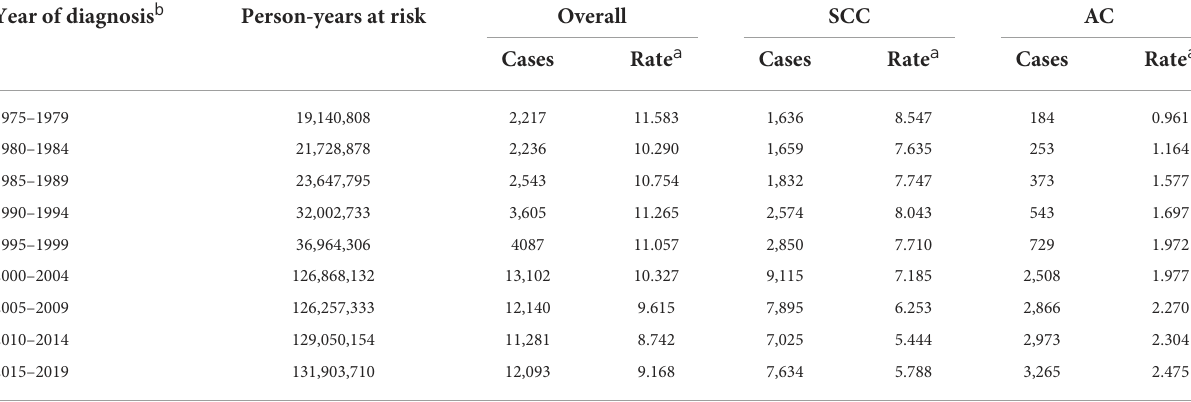
TABLE 1 Cases and rates on cervical cancer incidence (1975–2019) for females aged 20–44 years by histology and year of diagnosis, United States.